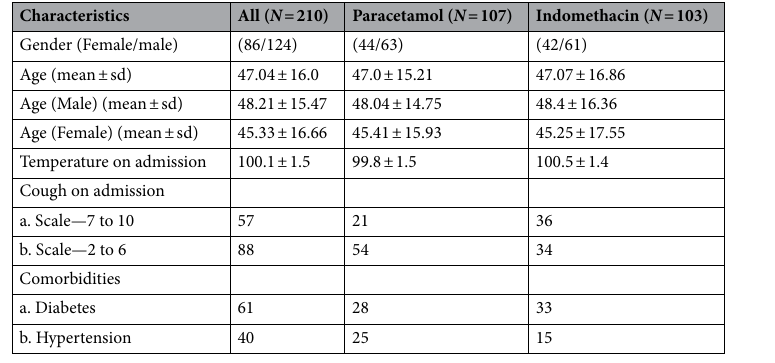
Table 2. The profile of the recruited